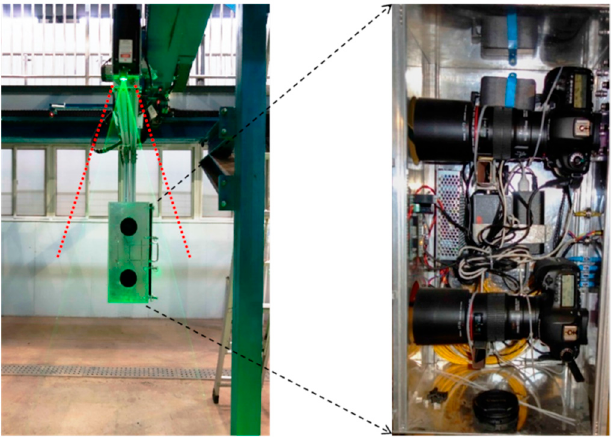
Figure 4. The image acquisition system.